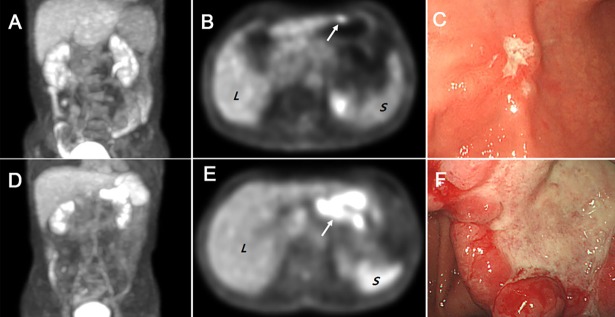
(A-C) A 53-year-old women with stomach cancer underwent FDG PET/CT. The maximum intensity projection (MIP) image (A) and transaxial PET (B) show diffuse spleen (S) FDG uptake lower than liver (L) FDG uptake. The transaxial PET also shows a focal FDG uptake at the anterior wall of stomach antrum (arrow), which is matched lesion with endoscopic finding (C). The calculated SLR was 55.87. After subtotal gastrectomy, final pathology confirmed stage of early gastric cancer (pT1N0M0) and histologic type of signet ring cell carcinoma. She had no recurrence during the follow up period of 48.9 months. (D-F) A 57-year-old man with stomach cancer underwent FDG PET/CT. The maximum intensity projection (MIP) image (D) and transaxial PET (E) show diffuse spleen (S) FDG uptake higher than liver (L) FDG uptake. The transaxial PET also shows a focal FDG uptake at stomach antrum (arrow), which is matched lesion with endoscopic finding (F). The calculated SLR was 123.31. After distal gastrectomy, final pathology confirmed stage of advanced gastric cancer (pT4aN3bM0) and histologic type of poorly differentiated tubular adenocarcinoma. He had a peritoneal recurrence after 9.1 months and finally died after 13.2 months.